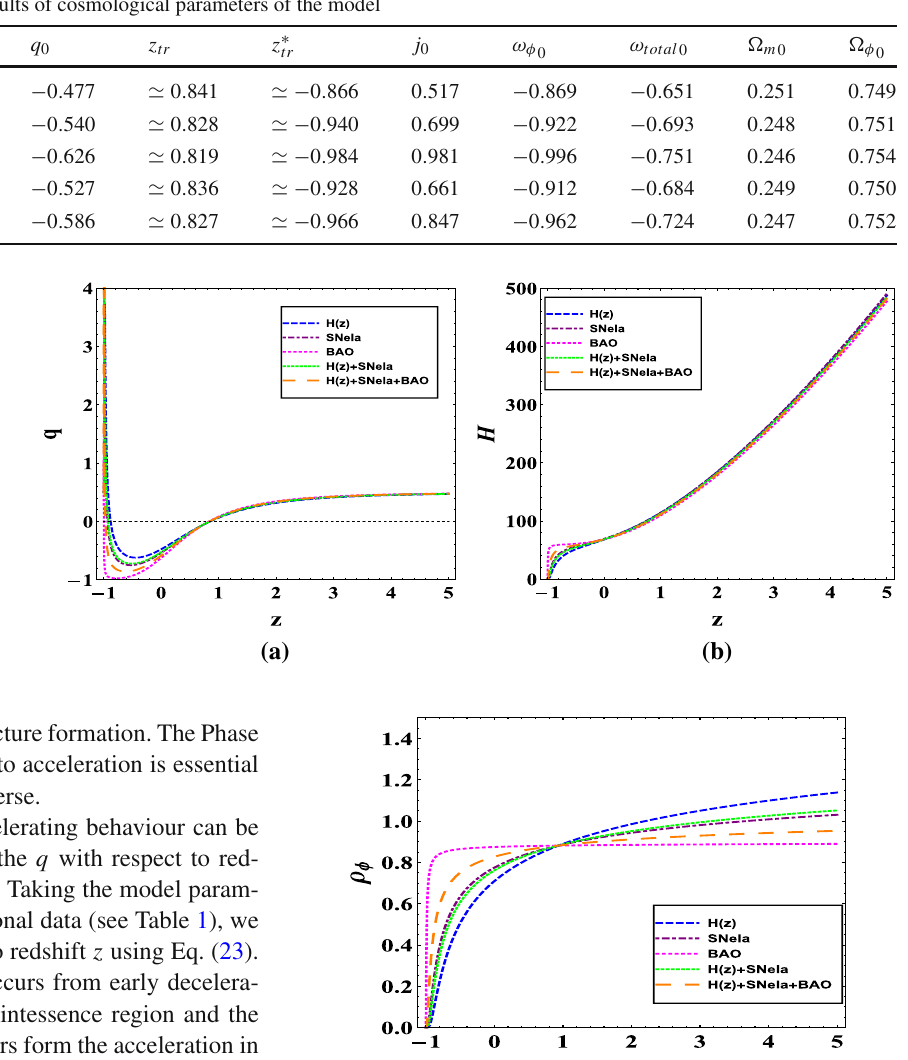
Fig. 5 The plot of energy density of scalar field ρ φ vs. redshift z for different observational